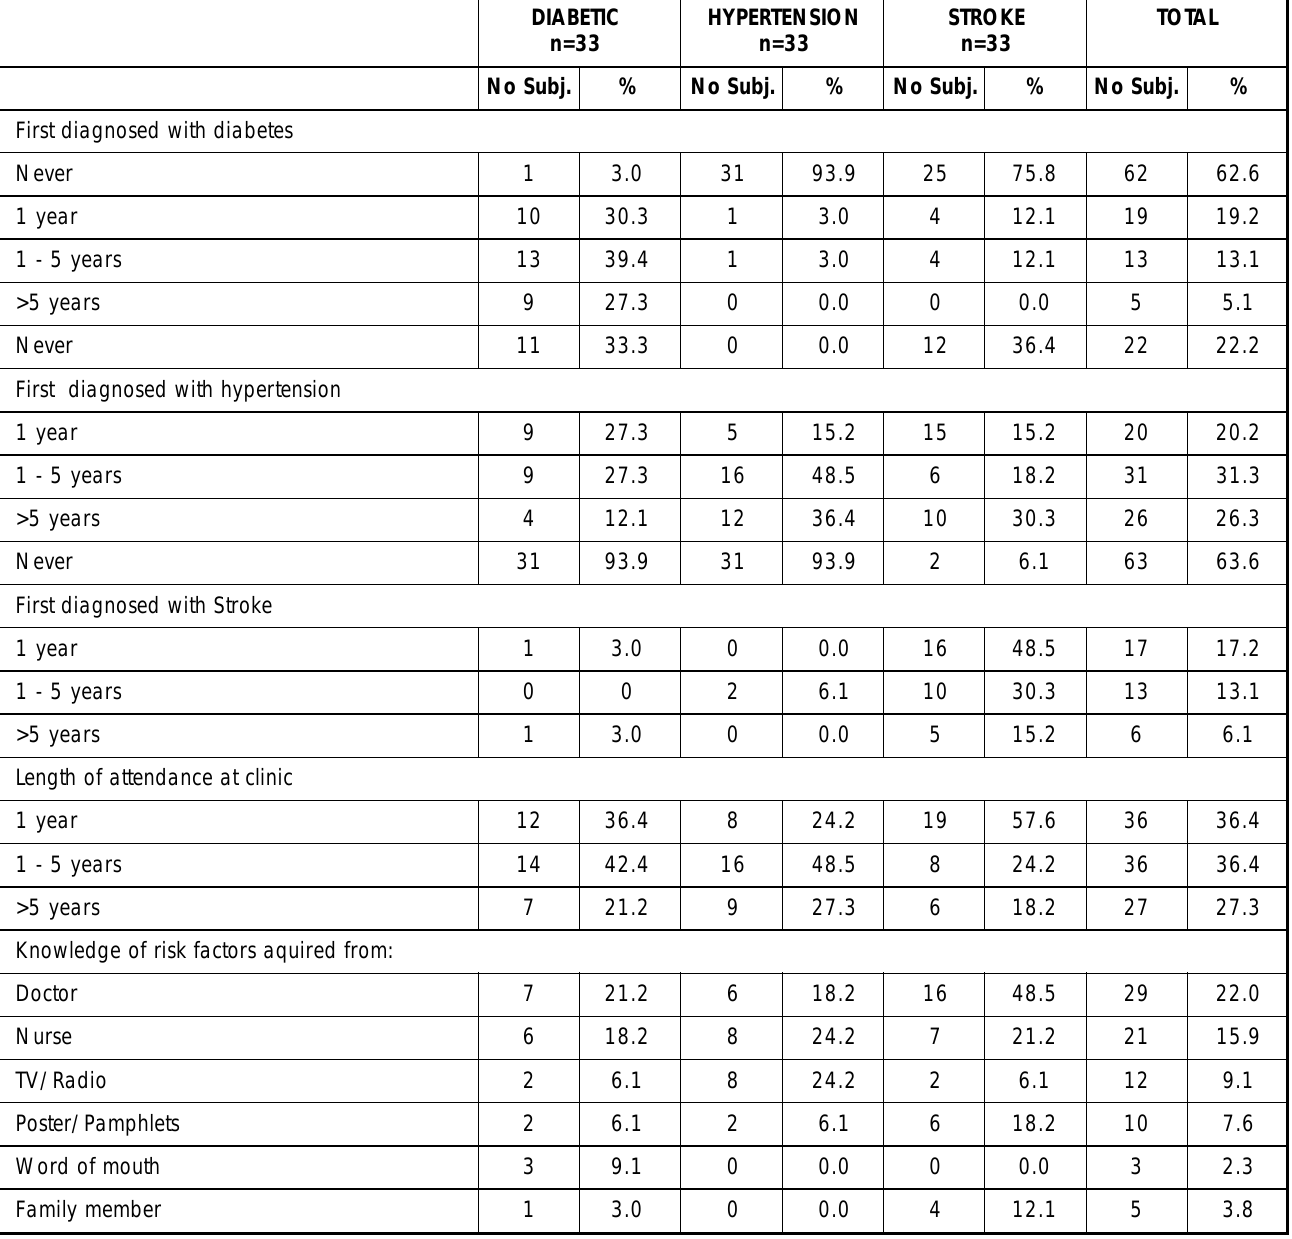
Table 2: Medical Information of all groups.